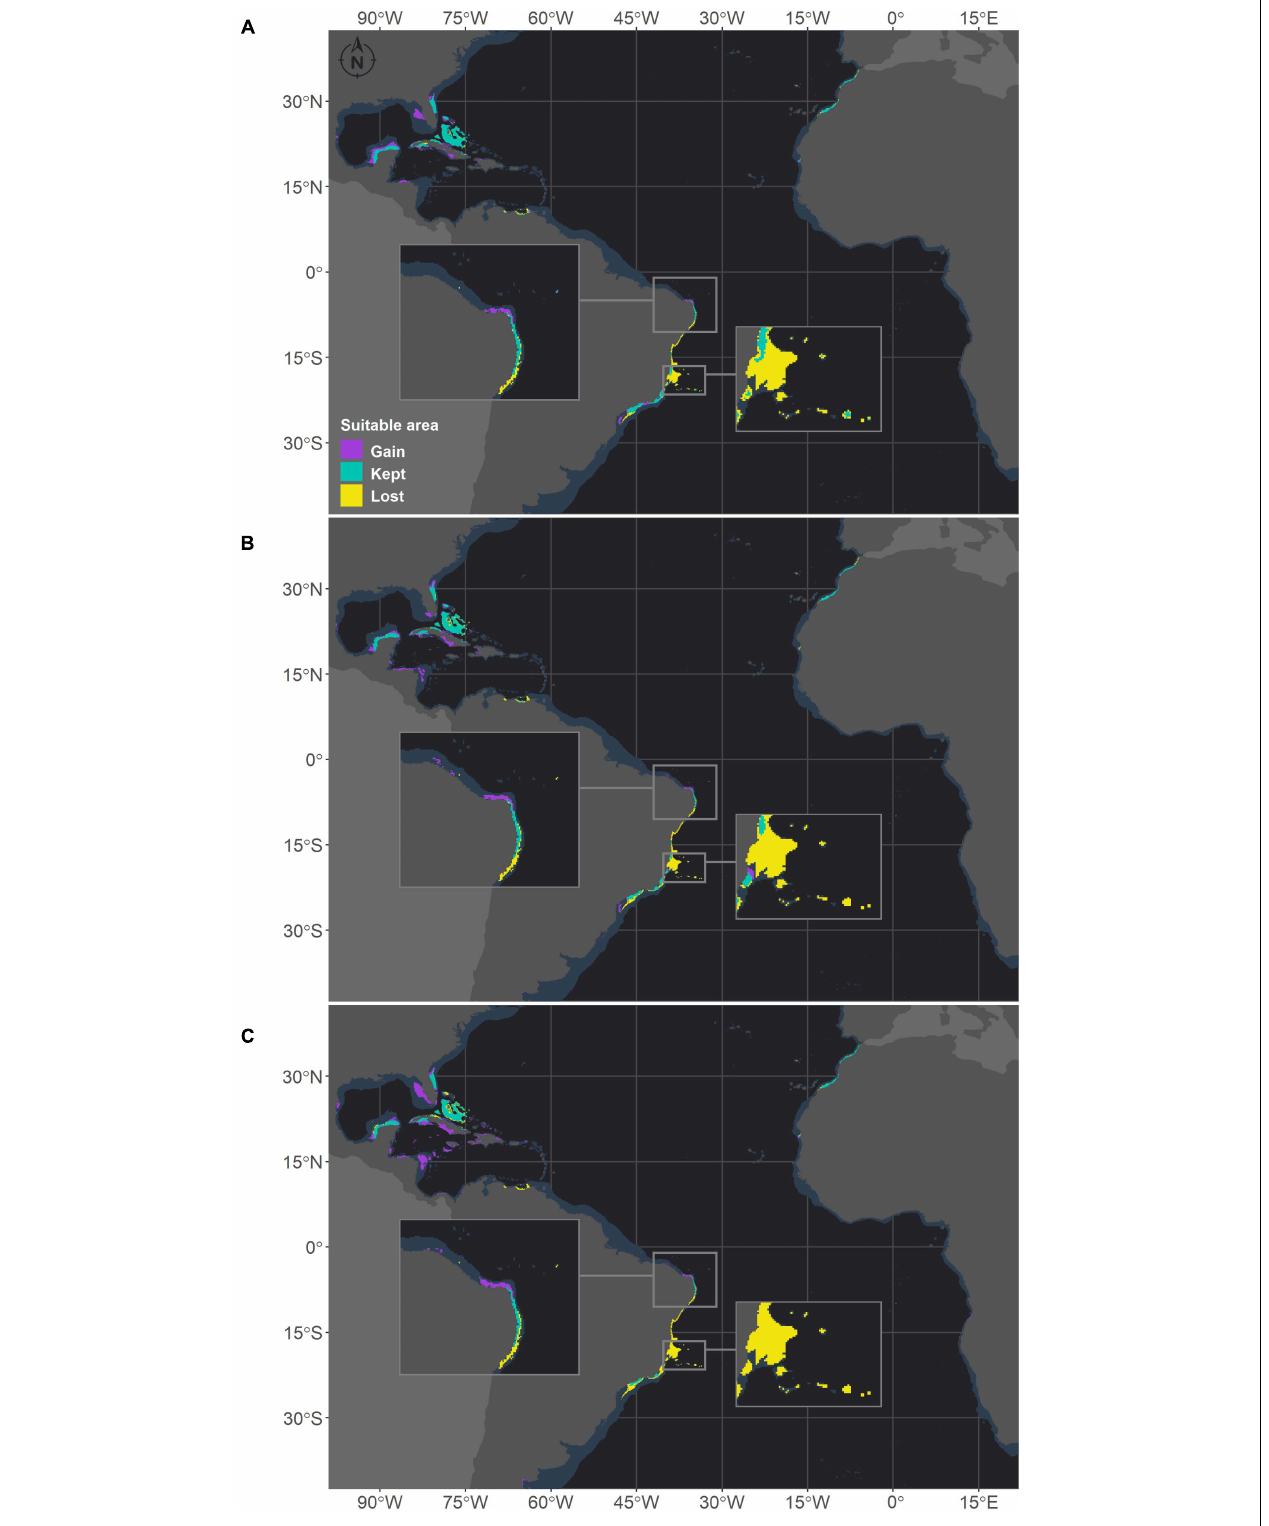
FIGURE 4 | Projected habitat suitabilities for future relative concentration pathway (RCP) scenarios for Mussismilia hispida in the Atlantic Ocean, obtained through an ensemble modeling approach. The models were trained on present-day data of each species and projected for the (A) RCP2.6, (B) RCP4.5, and (C) RCP8.5 scenarios. Inset maps highlight changes in northern Brazil (top) and in the Abrolhos region (bottom).